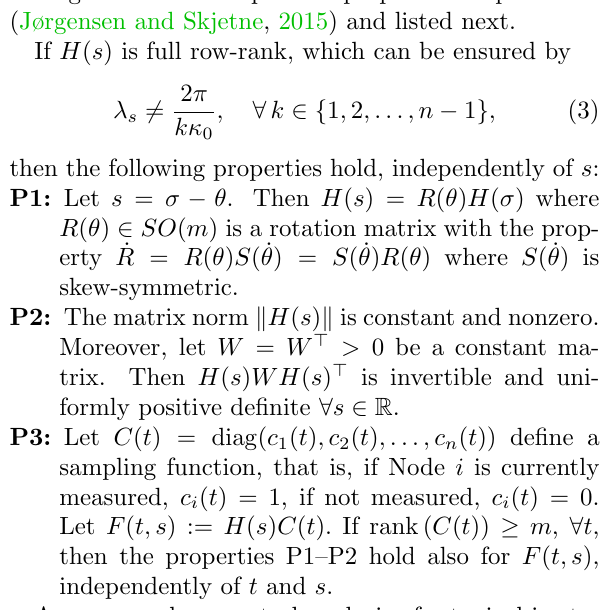
Figure 14: AUV scanning area of the drifting ice field, with is discretized into a grid of nodes. For each node the ice draft estimated and re- peatedly measured by the circling AUV and an upward-looking MBES. Courtesy: Ulrik Jørgensen.